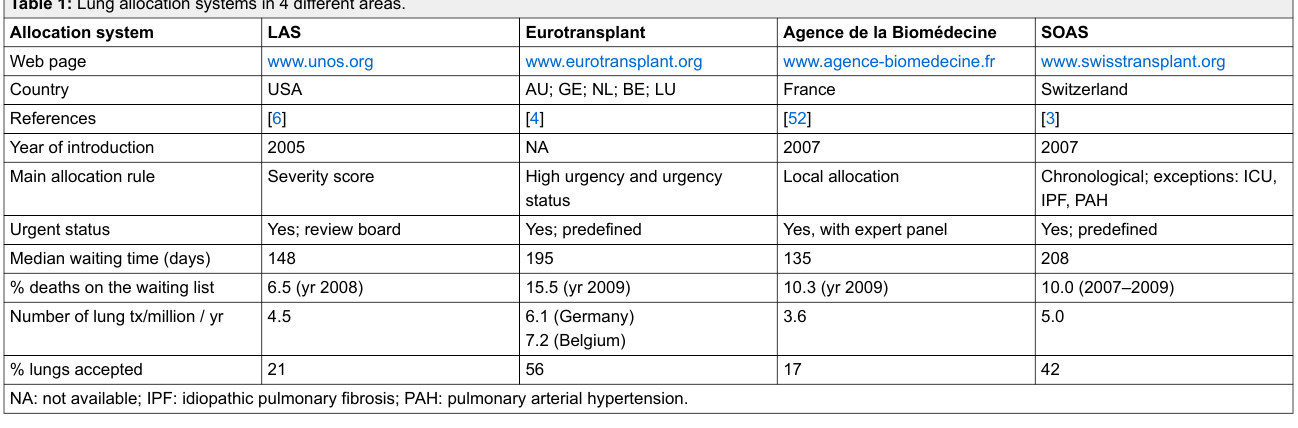
Main allocation rule